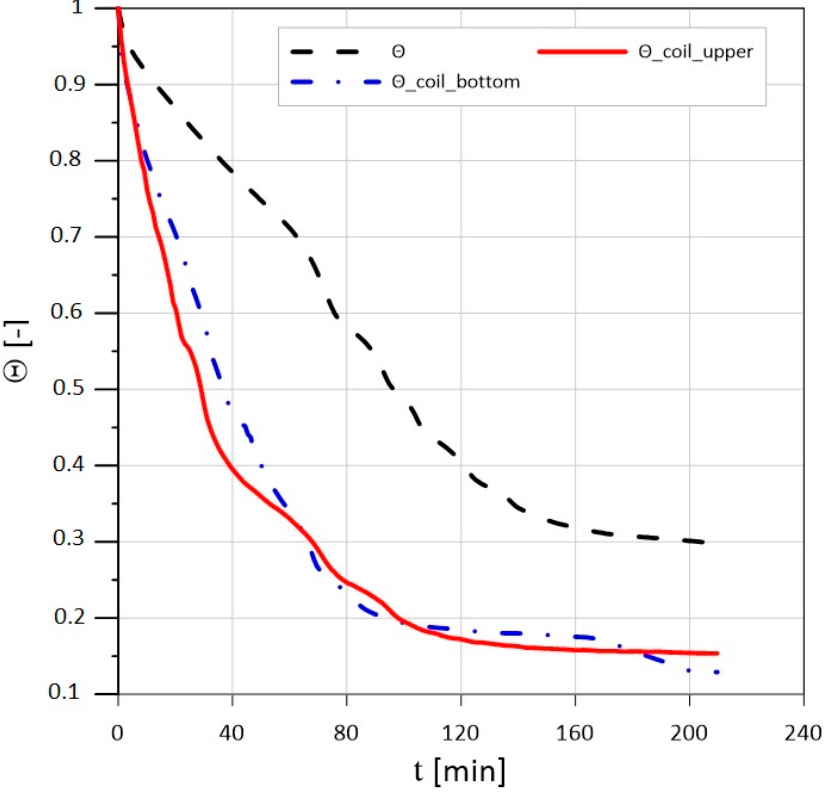
Figure 21. Dimensionless, volume-averaged temperature vs. time during the melting process with a constant wall temperature condition .